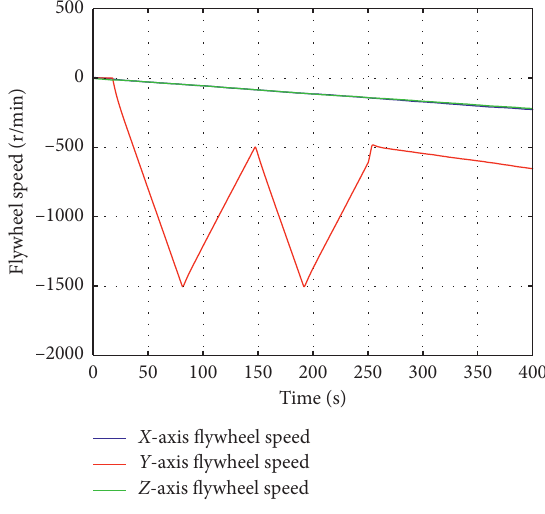
Figure 7: Flywheel